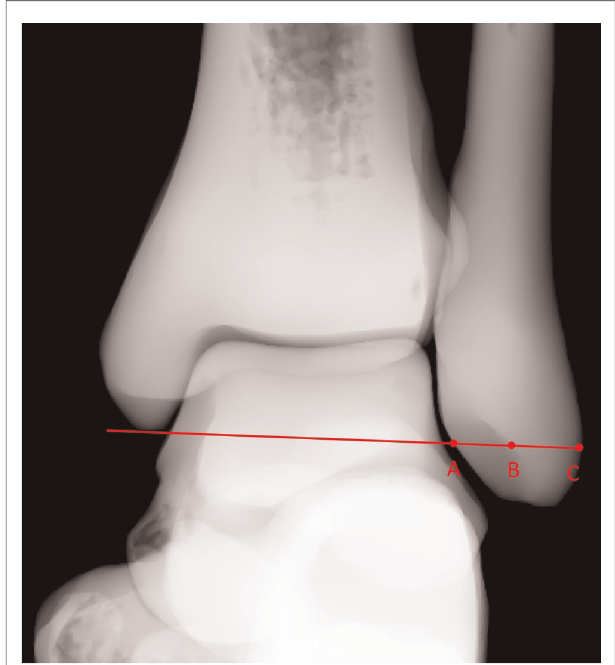
FIGURE 5 | Line drawn through the tip of the medial malleolus and parallel to the distal tibial plafond that intersected the medial edge of the fi bula at point A, intersected the lateral malleolar fossa cortex at point B, and intersected the lateral edge of the fi bula at point